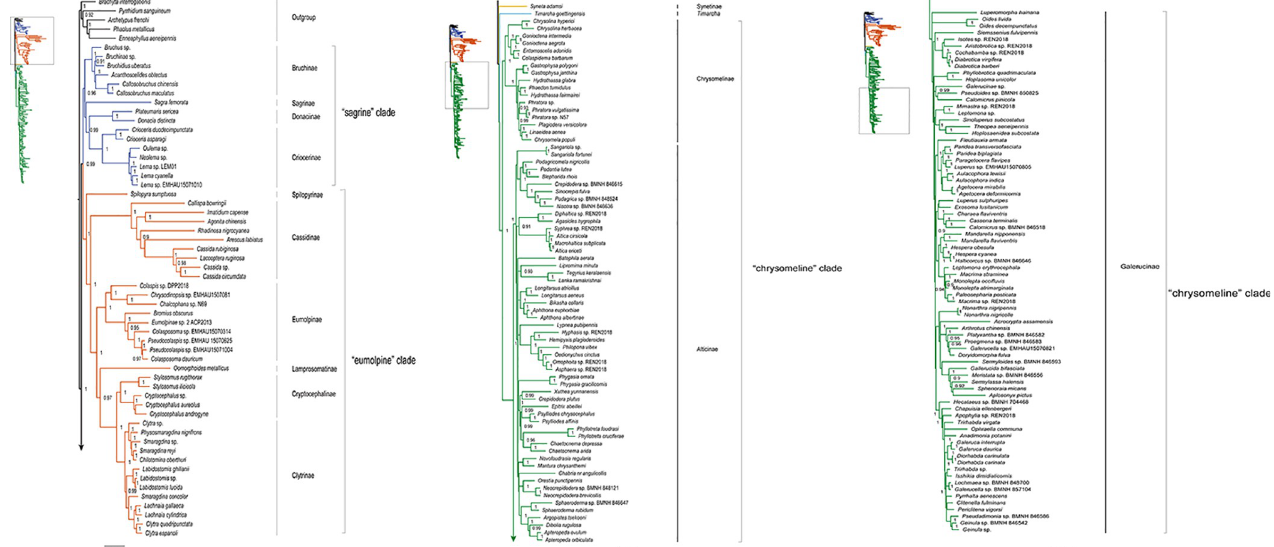
Fig 4. Bayesian tree inferred from the dataset PCG_aa using PhyloBayes under the site-heterogeneous CAT model. Node numbers show the posterior probability values.